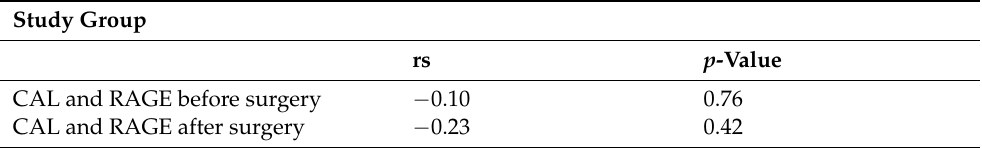
Table 2. The correlations between the results of CAL levels and RAGE/AGER levels before and after surgical